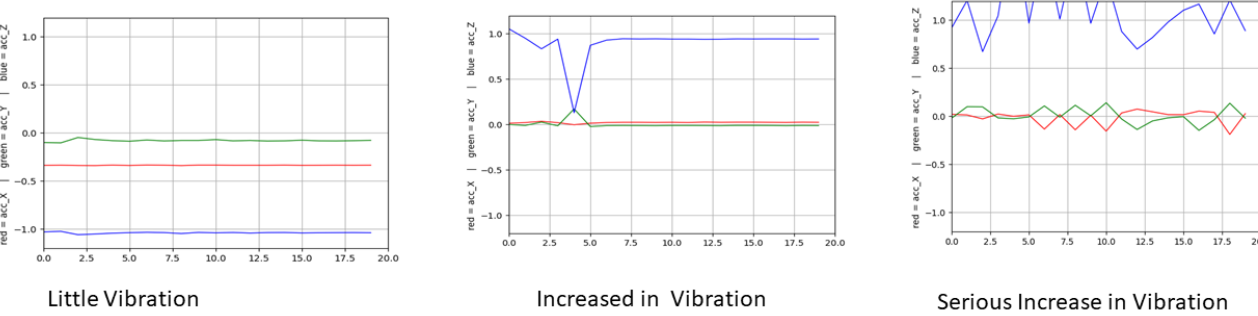
Figure 3. Visualizing the vibration data. Here, the sensor connect shows the 3-axis data of the vibration sensor for little vibration, moderate vibration, and intense